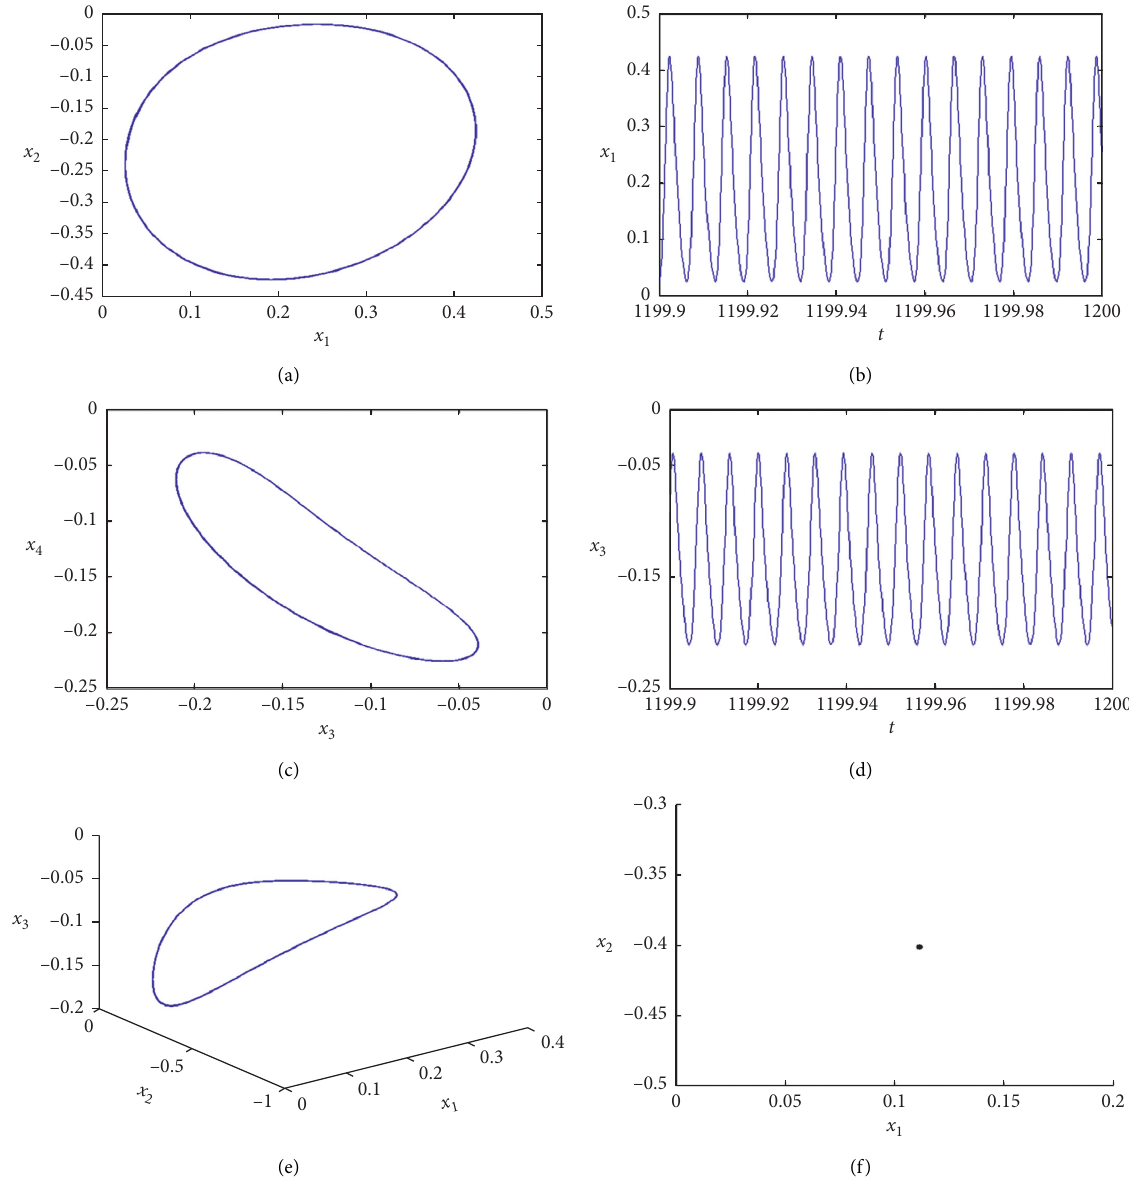
Figure 9: The periodic oscillation of the cantilevered pipe conveying pulsating fluid is obtained when the parametric excitation of the flow � 11 . 0. (a) Phase portrait on plane ( x velocity is U 0 ) , (e) three-dimensional phase portrait in space ( x on plane ( t, x 3 oscillation around the right-mode position and then there exists one-time oscillation around the left-mode position in the cantilevered pipe conveying pulsating fluid, as shown in Figure 11(d). Figure 12 indicates that there exist the multitime chaotic oscillations when the velocity parametric excitation is U � 31 . 5. Around the left-mode and right-mode positions, 0 the chaotic oscillations of the cantilevered pipe conveying